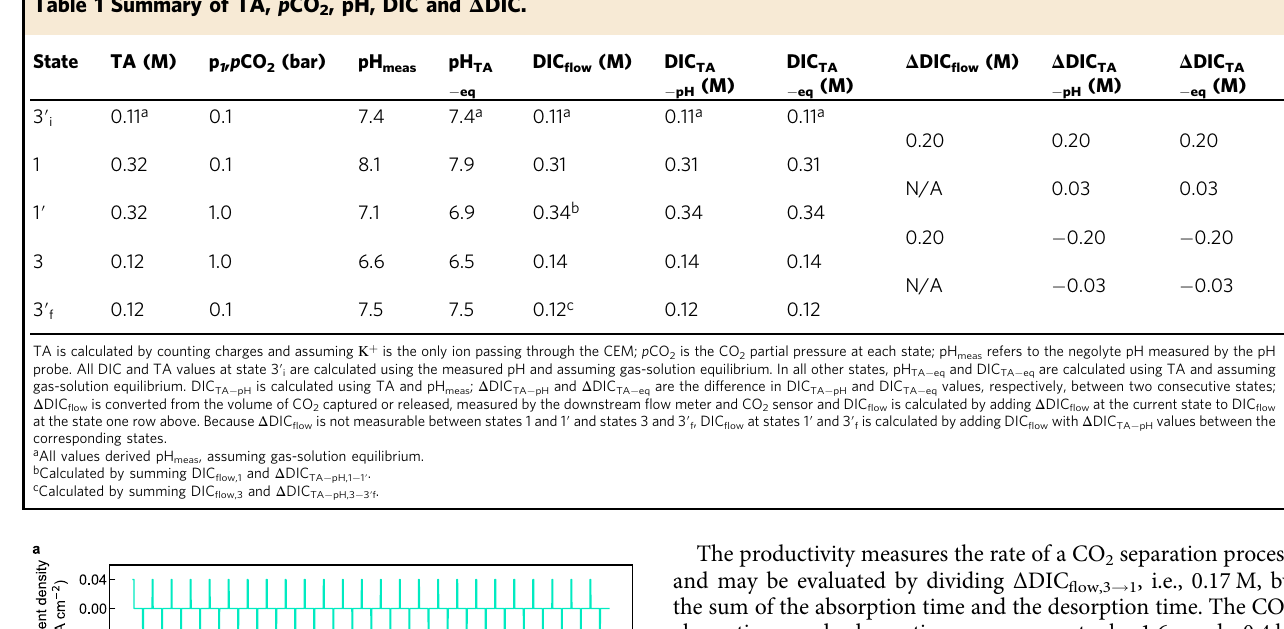
Table 1 Summary of TA, p CO 2 , pH, DIC and Δ DIC.